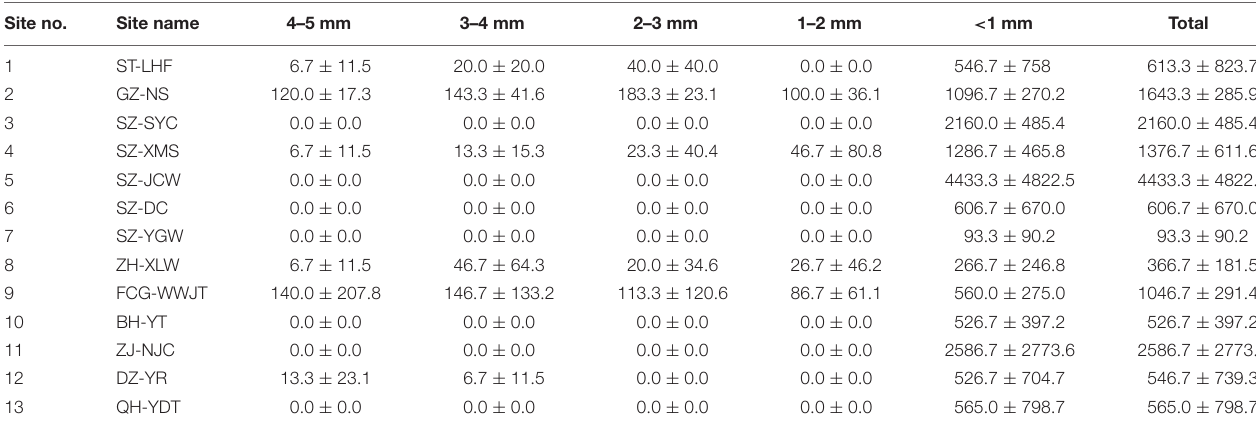
TABLE 1 | Size distribution and abundance of microplastics (MPs; n kg − 1 ) in the surface sand (0–5 cm) collected from the beach along the coasts of South China. Site